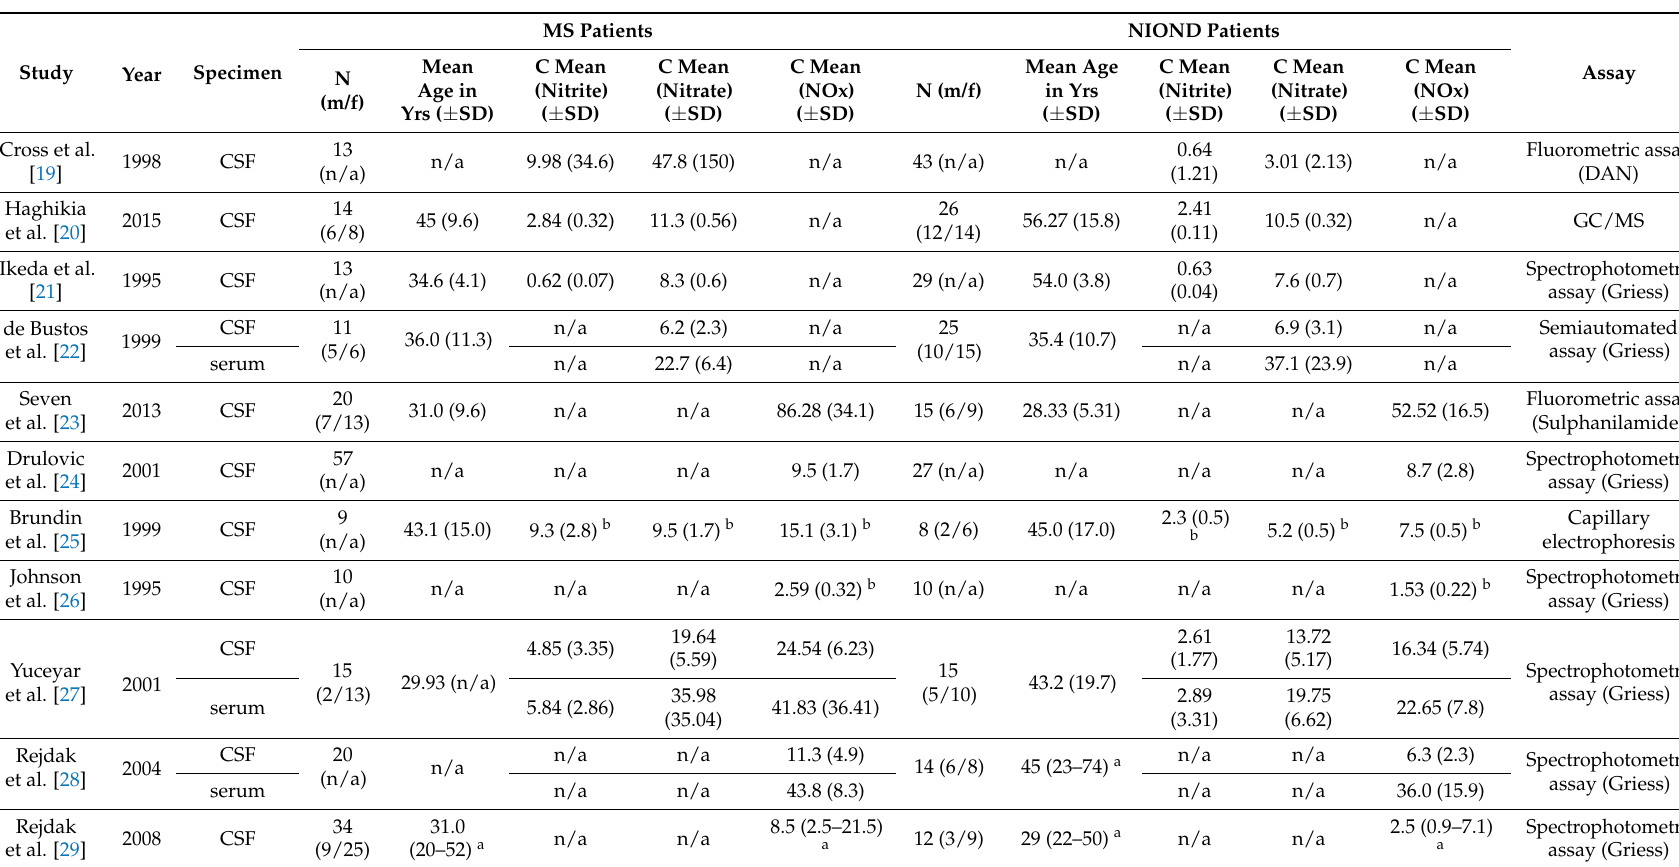
Table 1. Characteristics of included studies investigating nitrite and/or nitrate levels in multiple sclerosis patients (MS) versus patients with noninflammatory other neurological diseases (NIOND). CSF = cerebrospinal fluid, NOx = sum of nitrite and nitrate, C = concentration in µ M, SD = standard deviation, SEM = standard error of mean, IQR = interquartile range, n/a = data not given or not applicable, GC–MS = gas chromatography–mass spectrometry, DAN =